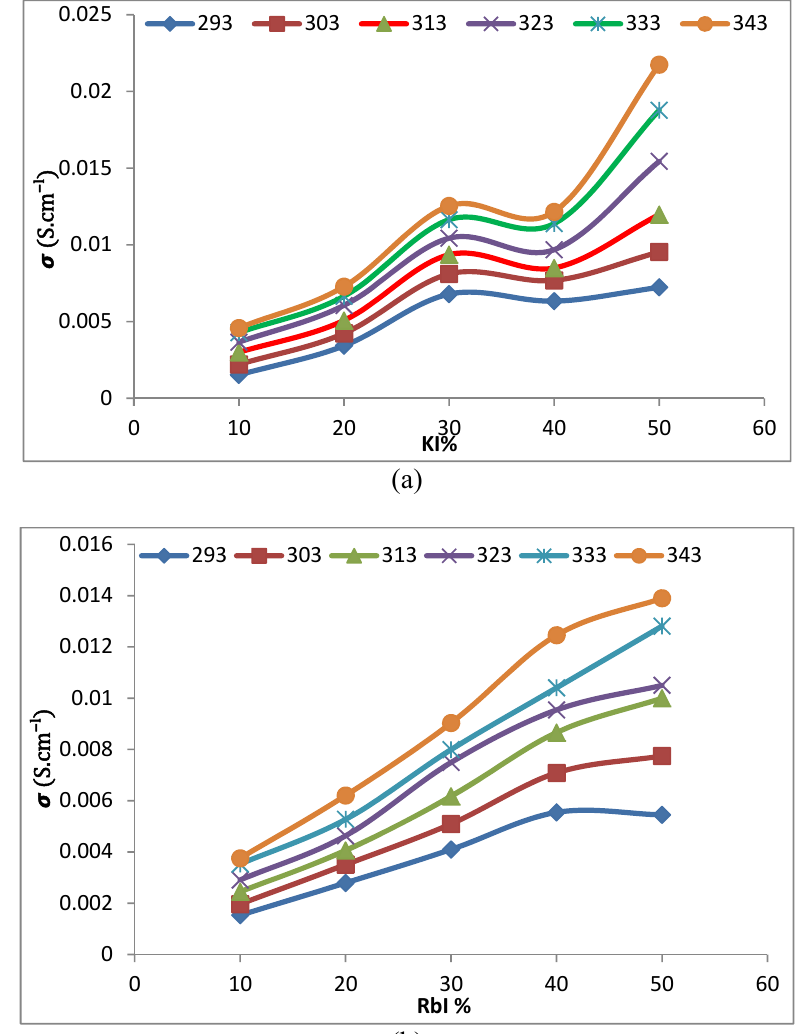
Fig.2: Dependence of ionic conductivity on KI & RbI weight ratio in the gel polymer electrolytes (a) S and (b) H.